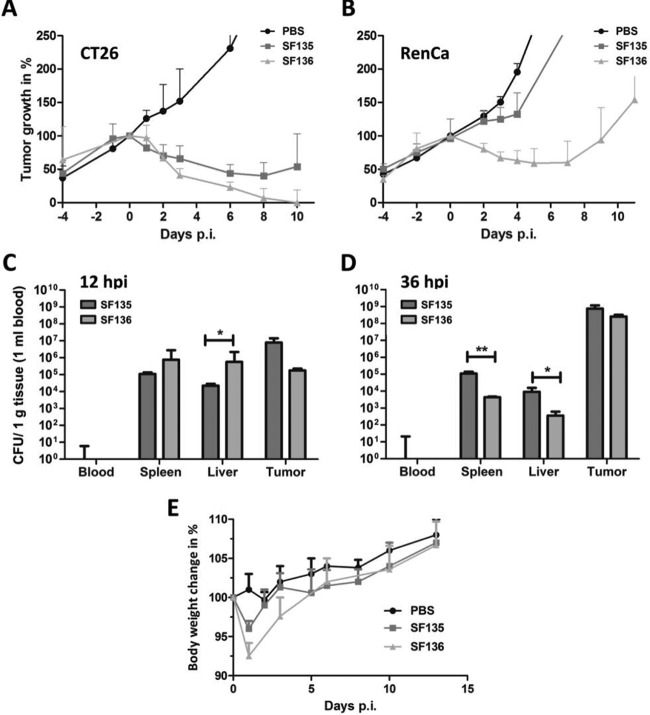
Therapeutic benefit of ΔaroA in bacterium-mediated tumor therapy. Immunogenic CT26 (A)- and aggressive RenCa (B)-bearing mice were infected i.v. with 5 × 106 SF135 (ΔrfaG) or SF136 (ΔaroA ΔrfaG) bacteria. The tumor volume was monitored, and the medians with ranges are displayed. (C and D) Blood, spleen, liver, and tumor bacterial burdens of CT26-bearing mice were determined by plating serial dilutions of tissue homogenates. CFU counts of SF135 and SF136 at 12 hpi (C) and 36 hpi (D). (E) Body weight measurement as indicator for general health status upon infection with LPS variants. Results are representative for two independent experiments with 5 replicates per group. *, P < 0.05; **, P < 0.01.